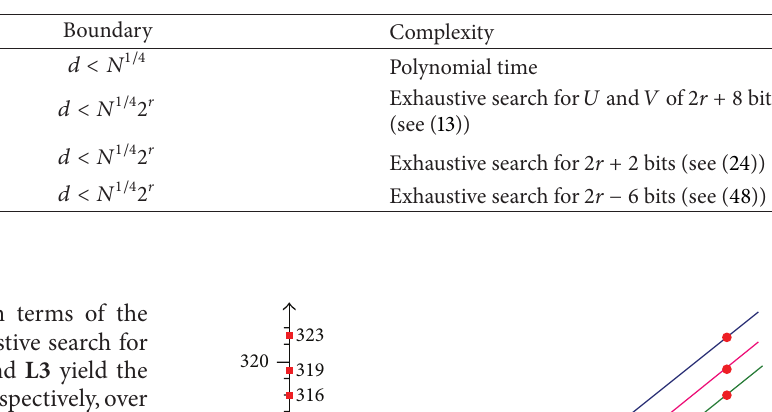
Table 3: The improvement between each attack.